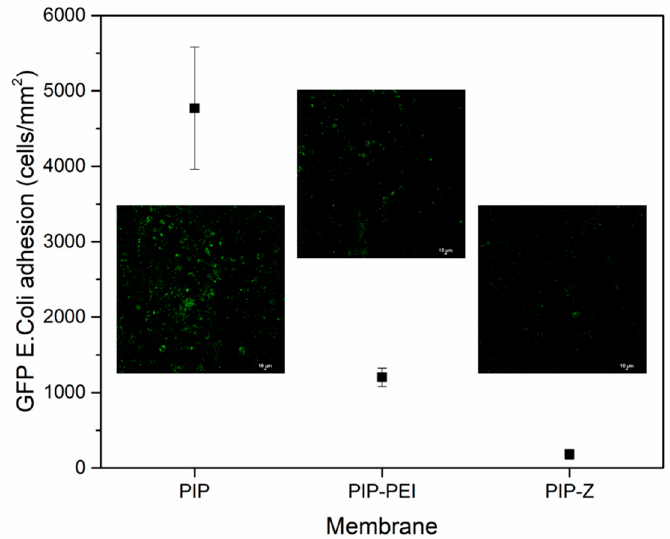
Figure 7. Confocal microscopic images of the TFC nanofiltration membranes after incubation using GFP- E. coli solution for 24 h as obtained during bacterial attachment test.